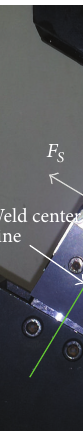
Figure 2: Experimental setup for 𝜙 = 30 ∘